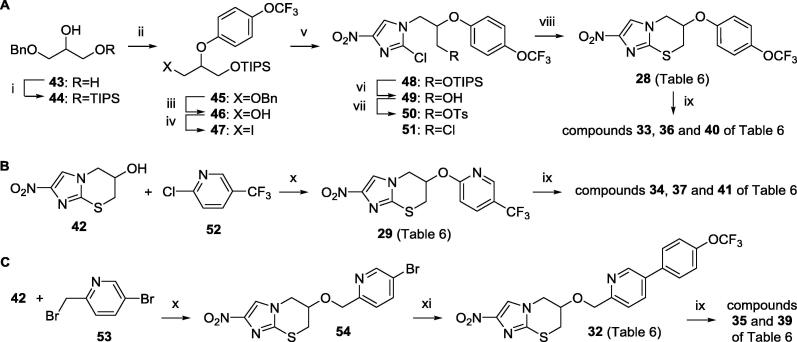
Reagents and conditions: (i) TIPSCl, imidazole, DMF, 20 °C, 3 d (92%); (ii) 4-OCF3PhOH, PPh3, DEAD, THF, 0–20 °C, 4.5 d (75%); (iii) H2, 10% Pd-C, EtOH, EtOAc, 2 d (98%); (iv) I2, PPh3, imidazole, CH2Cl2, 20 °C, 15 h (98%); (v) 2-chloro-4-nitroimidazole, K2CO3, DMF, 85 °C, 64 h (88%); (vi) TBAF, THF, 0–5 °C, 5 h (83%); (vii) TsCl, pyridine, 0–20 °C, 25 h (50: 84%; 51: 9%); (viii) LiSTIPS, THF, −78 to 20 °C, 2 d, then TBAF, THF, 20 °C, 13 h (31%); (ix) m-CPBA, Na2HPO4, CH2Cl2, −10 to 20 °C, 23–52 h (33: 82%, 36: 2%, 40: 11%; 34: 60%, 37: 11%, 41: 28%; 35: 55%, 39: 8%); (x) NaH, DMF, 0–20 °C, 3–3.5 h (29: 69%; 54: 79%); (xi) 4-OCF3PhB(OH)2, toluene, EtOH, DMF, 2M Na2CO3, Pd(dppf)Cl2 under N2, 84 °C, 4.5 h (44%).